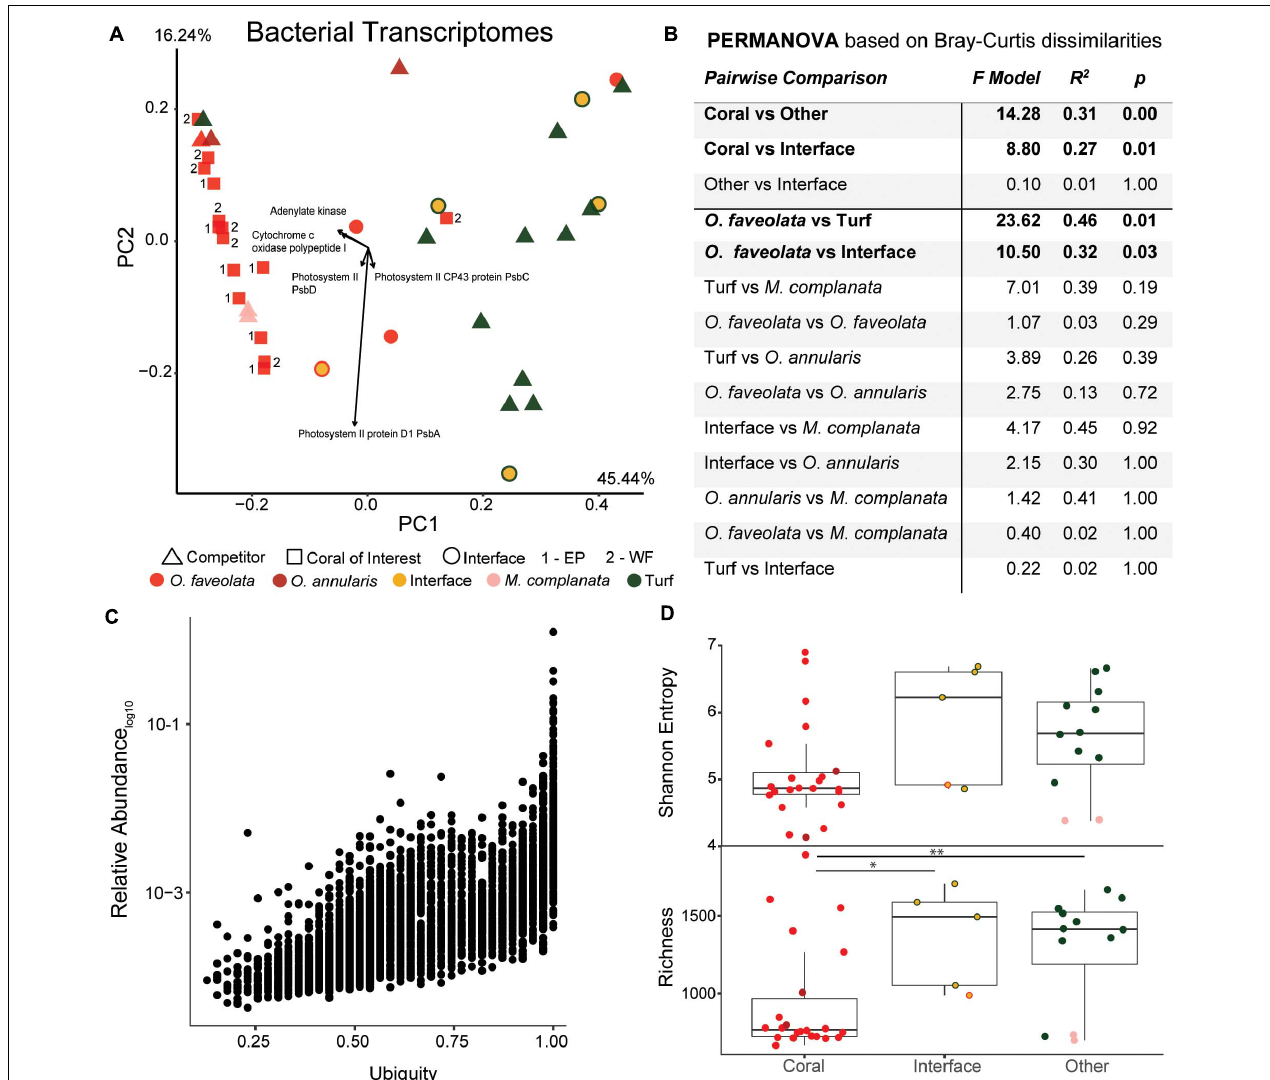
FIGURE 5 | Overview of the bacterial metatranscriptomes at the SEED functional level. (A) Principal components plot of the coral colonies of interest along with interfaces and their respective benthic competitors. EP, East Point coral of interest; WF, Water Factory coral of interest. (B) PERMANOVA results based on Bray-Curtis dissimilarities. (C) Relative abundance as a function of ubiquity of each bacterial transcript from all samples. The majority of bacterial transcripts were found in most samples (ubiquitous), and no Orbicella faveolata specific bacterial transcripts were observed. (D) Diversity metrics of coral, interface and other (turf algae and Millepora complanata ) samples at the SEED functional level. Richness of bacterial transcripts was significantly higher in interface and other samples than in corals (* p ≤ 0.05, ** p ≤